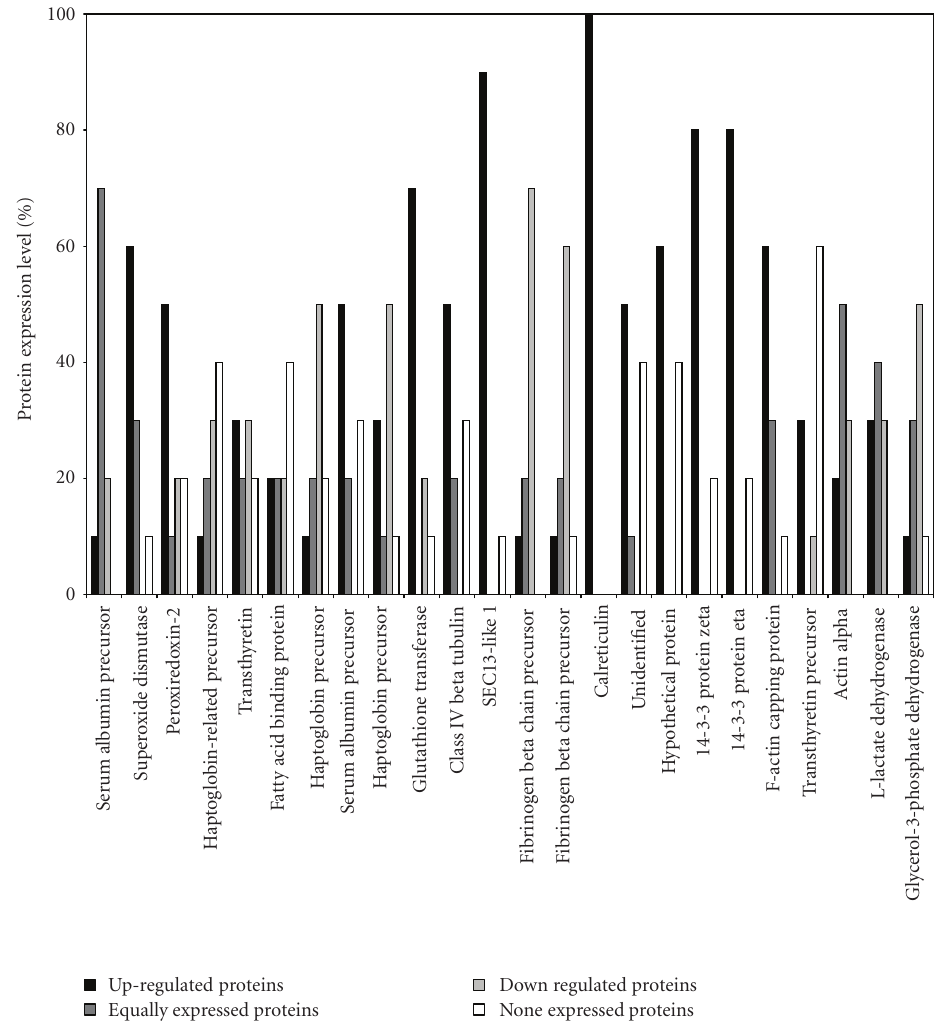
Figure 7: Distribution of proteins in Stage III